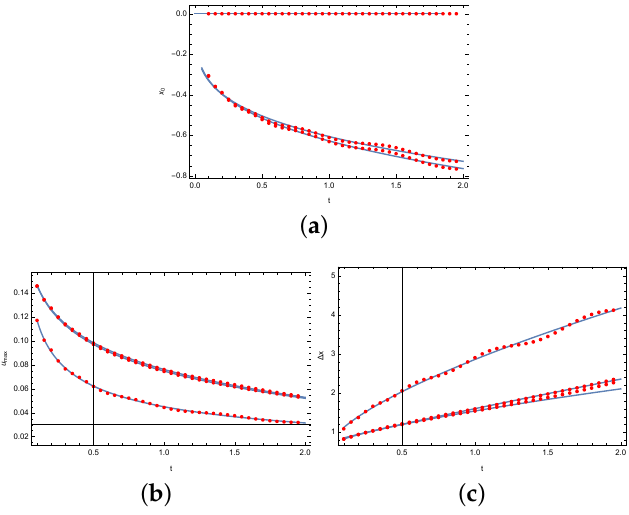
Figure 4. ( a ) Location of the maximum x 0 as a function of time. The top curve shows the location of the maximum where the skewness parameters are zero. The lower two curves represent the skewness for θ α = 0.21 and θ µ = − 0.1. The bending of the curve follows a relation x 0 ∼ t σ with σ ≈ 0.28; ( b ) decay of the maximum amplitude satisfies the relation u max ∼ exp ( − δ t γ ) with γ ≈ 0.1; and ( c ) change of (cid:14) e . The width changes according to the relation ∆ x ∼ t η with the width ∆ xd) at a level u max ( e − 1 ) η ≈ 0.67 for zero skewness (top curve) and η ≈ 0.9 with θ α = 0.21 and θ µ = − 0.1 (lower curve). Example 4. This example uses an external force w ( x ) = − 2sin 2 ( 2 π x ) with an initial condition x2 R u ( 0 ) ( x ) = 0.797885e − 2 sin 2 ( π x ) where the prefactor is chosen in such a way that the integral on